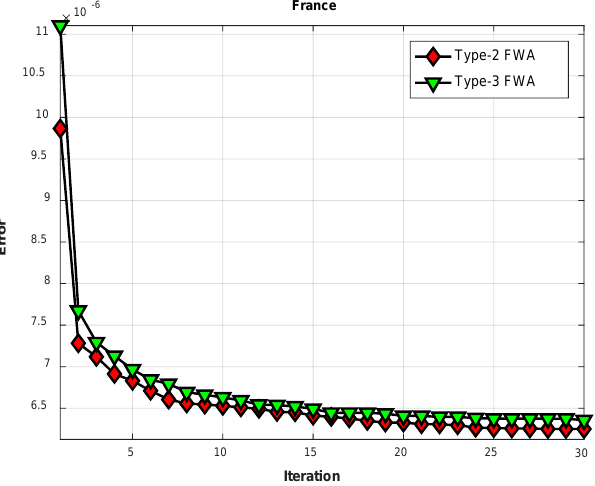
Figure 23. Type ‐ 3 fuzzy input variables (France): ( a ) fuzzy input #1; ( b ) fuzzy input #2; ( c ) fuzzy input #3.